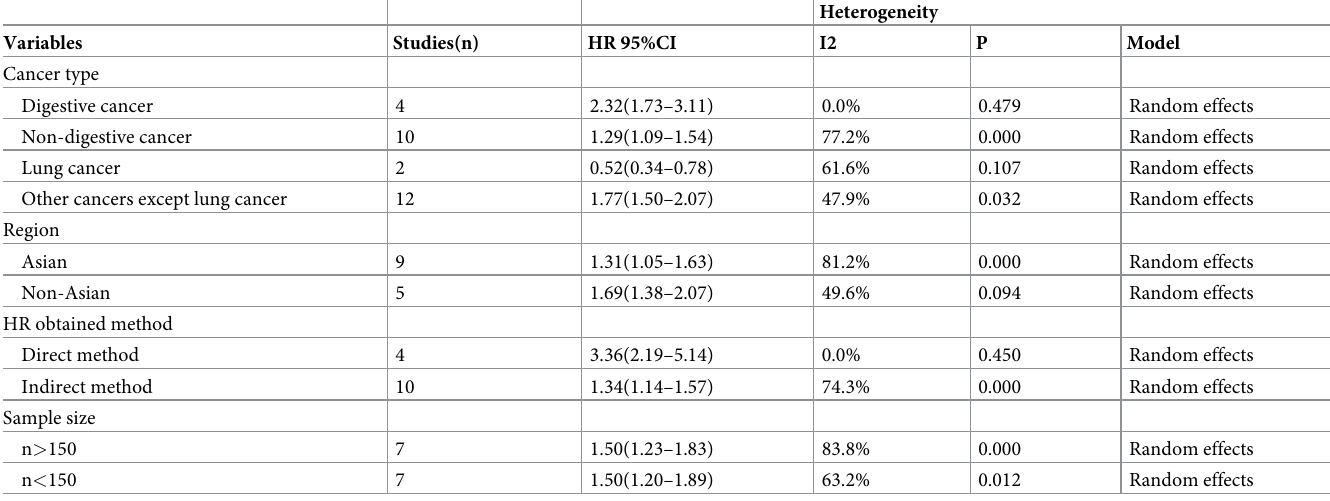
Table 2. Subgroup analysis for the correction between GPRC5A and